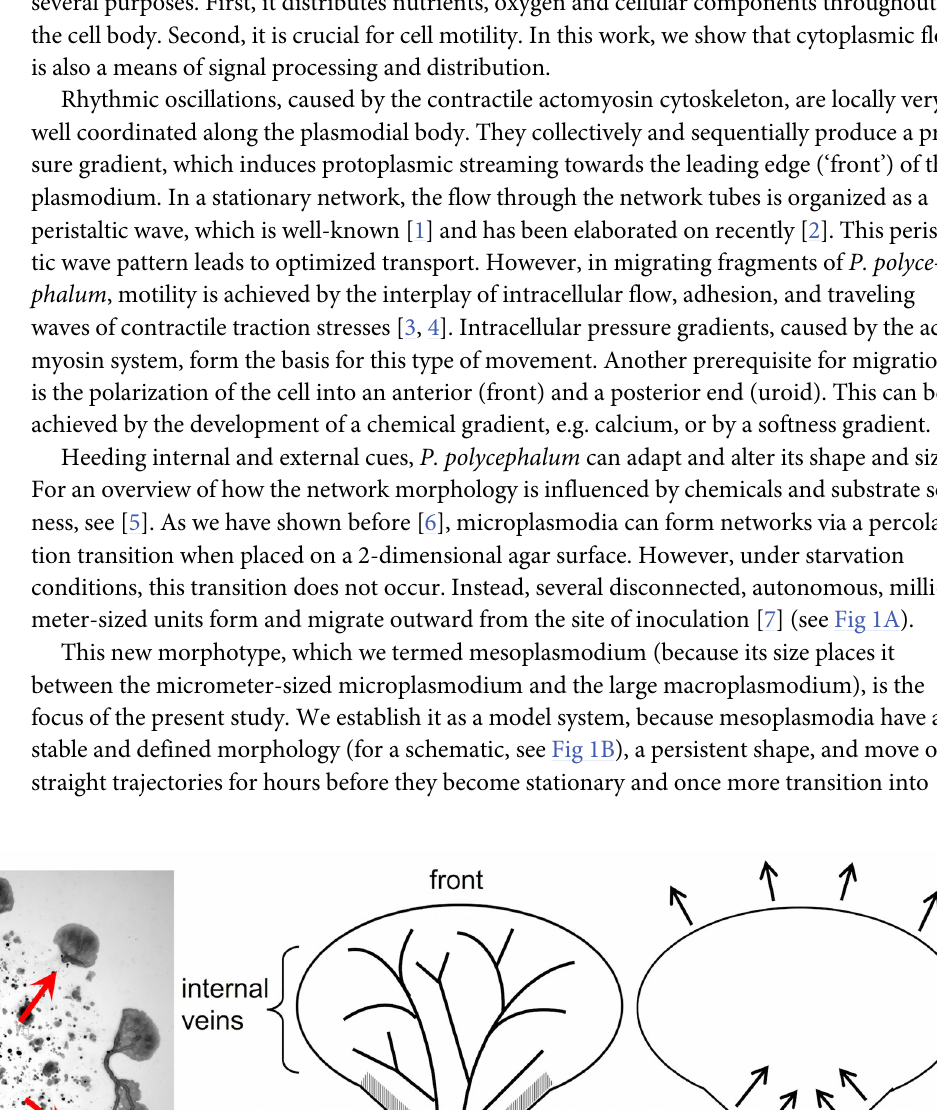
PLOS ONE | https://doi.org/10.1371/journal.pone.0215622 April 23,